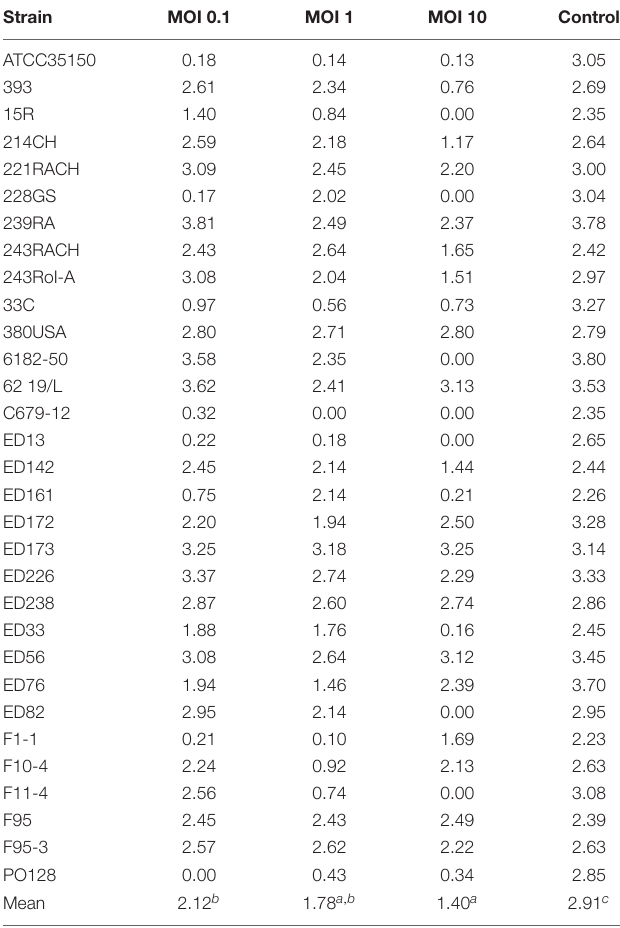
TABLE 2 | Values of area under the curve (auc) obtained by adding the phage cocktail to each strain with different Multiplicity of Infection (MOI). Strain MOI